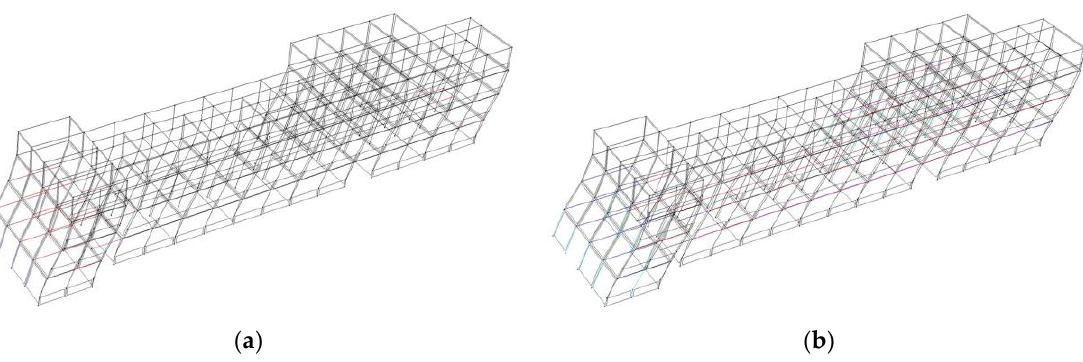
Figure 25. Hinge properties without WKDS. ( a ) DBE level, ( b ) MCE level.